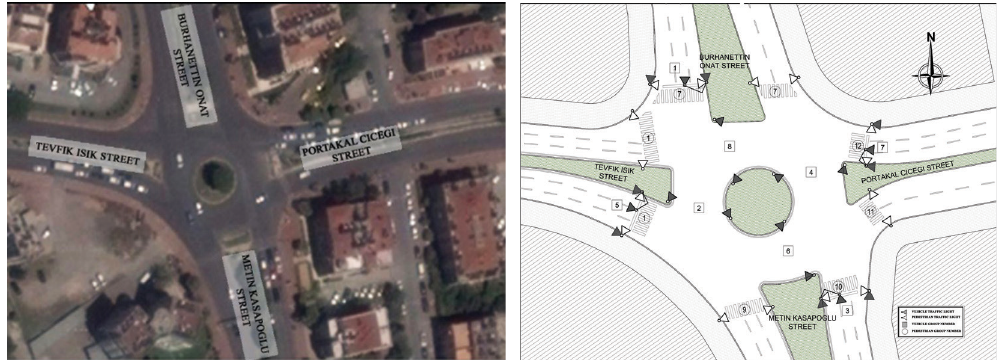
Figure 1. The image and plan view of Burhanettin Onat Street – Metin Kasapoglu Street roundabout in 2016 (by maps.google.com and by S. Ilyas, Y. User,